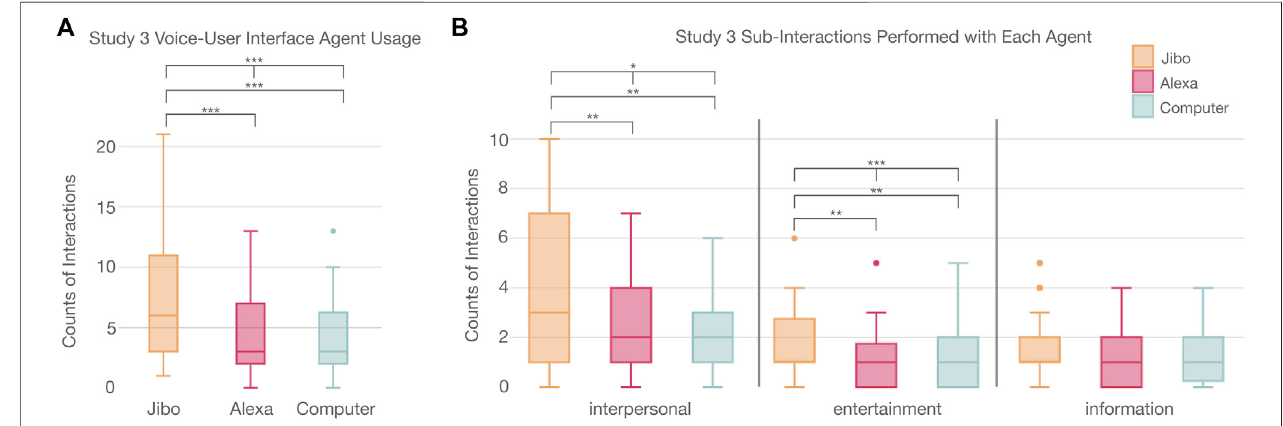
FIGURE 10 | (A) Signi fi cant trend in usage of voice agents between participants showing Jibo had a signi fi cant higher usage than Alexa or Computer. (B) Distribution of the interactions completed with various agents showing that participants engaged with agents different for interpersonal and entertainment based interactions.